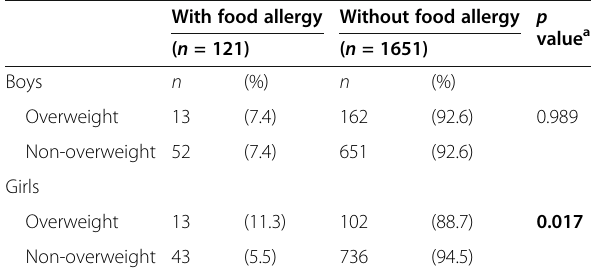
Table 3 The difference in the prevalence of food allergy between overweight and non-overweight by